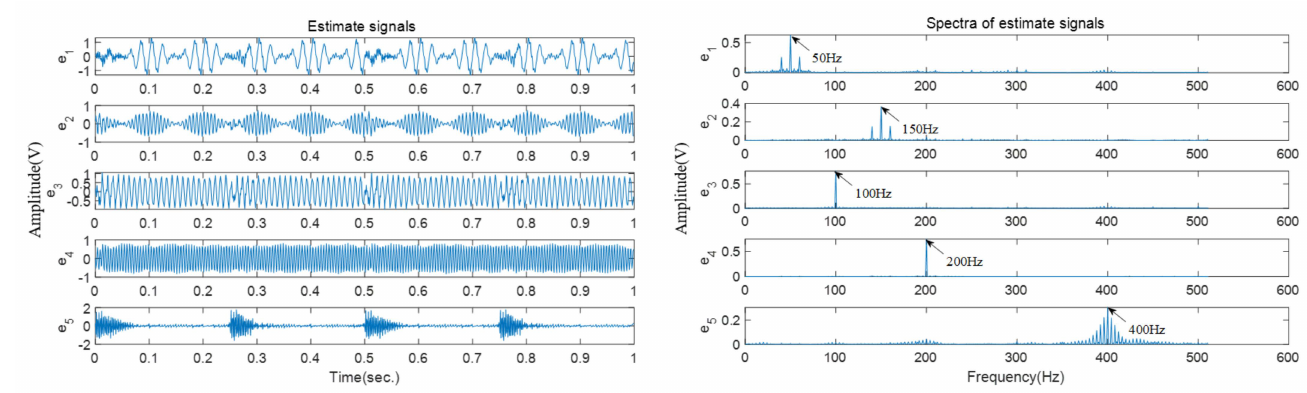
Figure 10. Time–domain waveforms and frequency spectra of the recovered